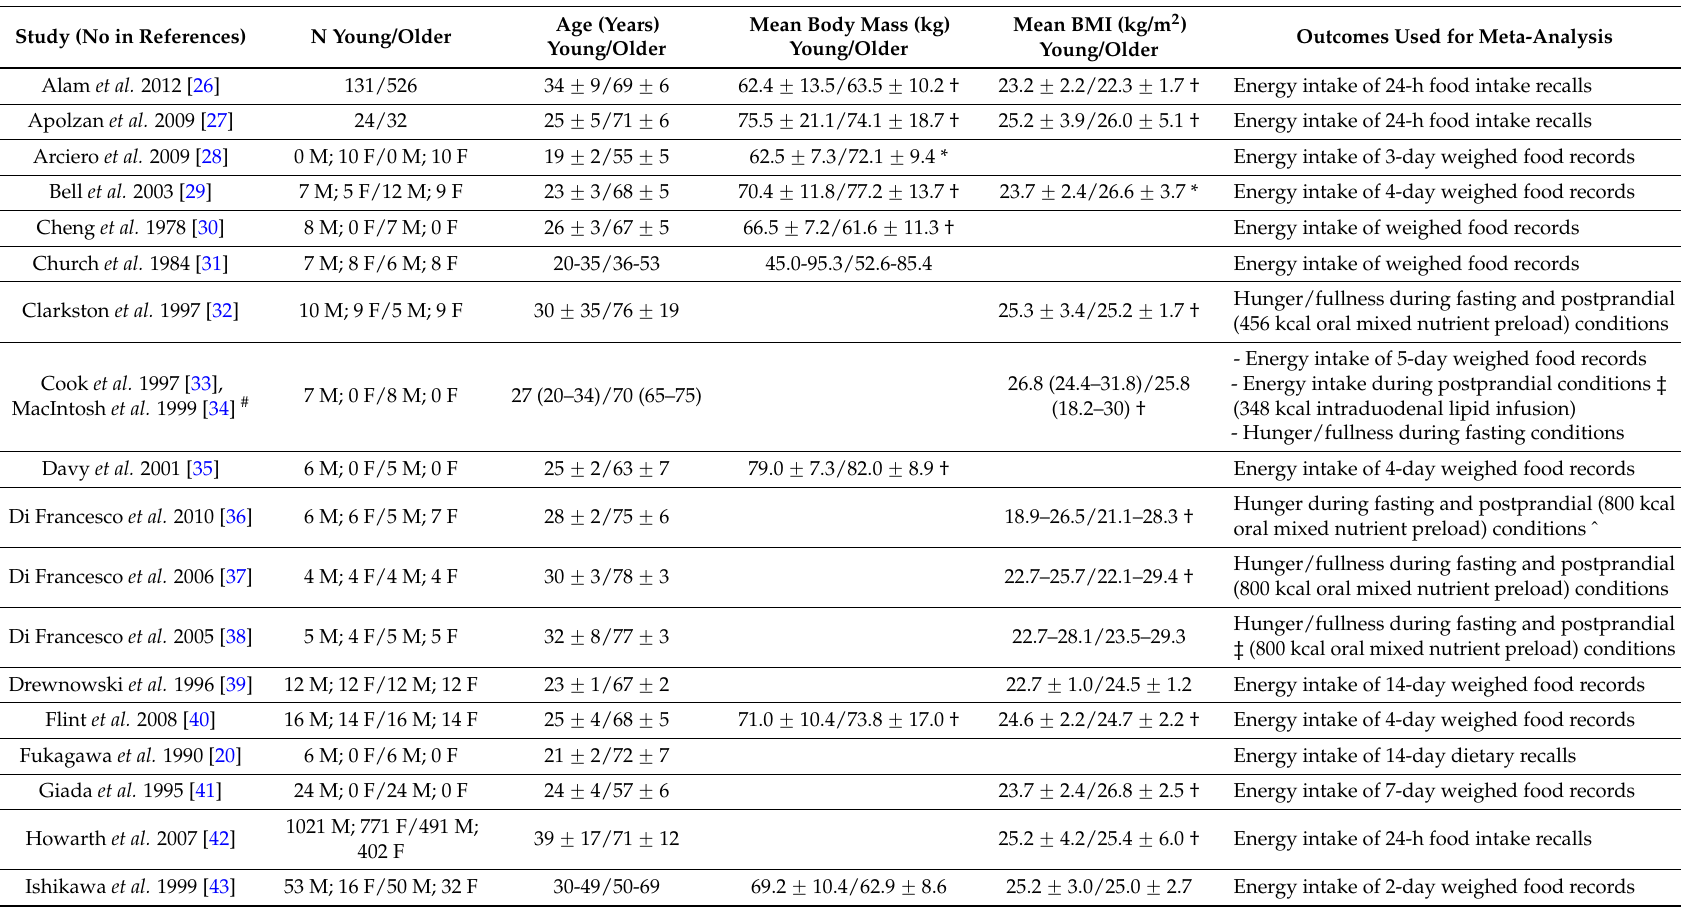
Table 1. Studies included in the